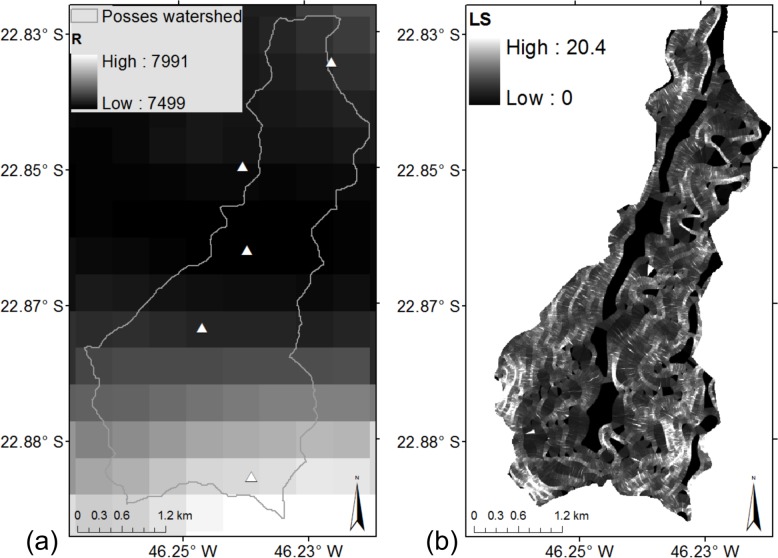
(a) Rainfall erosivity, in MJ mm ha-1h-1y-1, calculated from monthly precipitation data from five pluviometers spread out along the Posses watershed (white triangles), using data from Oct 2010 to Sep 2015. (b) Slope length-gradient factor (LS) input in InVEST Model, obtained from Zolin et al. [37].